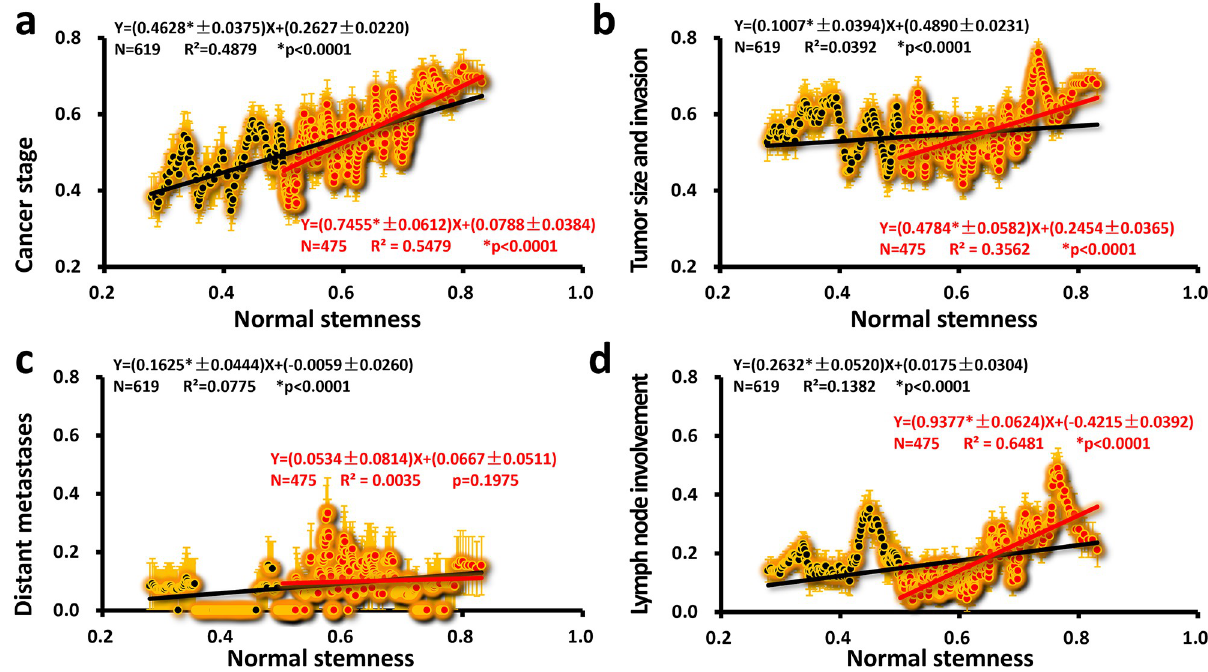
Fig 3. Four clinical data as a function of normal stemness. The linear regression results of the denoised clinical data (a: cancer stage; b: tumor size and invasion; c: distant metastasis; d: lymph node involvement) and Normal stemness in all intervals (0, 1) are shown as solid black lines, and black numbers represent the linear regression results on the interval (0.5, 1) with solid red lines and red numbers. Orange error bars show the calculated SEM while denoising. The error of the slope and intercept is directly expressed in the regression equation ( ± behind the value represents error; N is the total number of data; R 2 is the square of the correlation coefficient; p is the p -value for which the slope is not zero; � means significant).